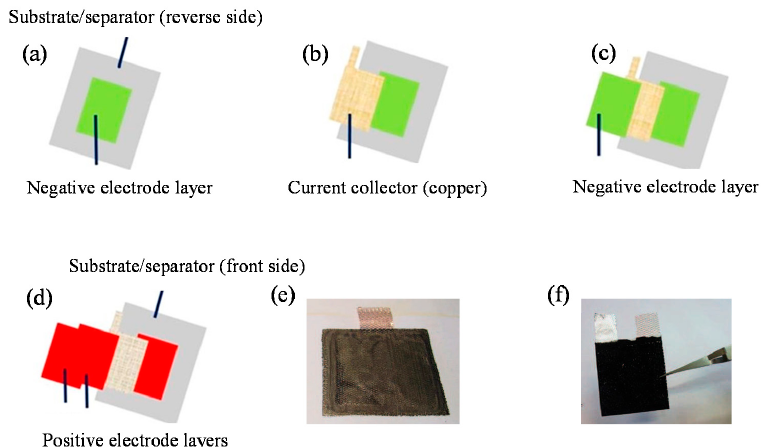
Figure 2. Schematic diagram showing the fabrication of the front/reverse assembled battery. ( a ) The negative electrode is printed onto the reverse side of the substrate; ( b ) the current collector is integrated in the structure, and ( c ) fixed with another printed layer. ( d ) On the front side of the substrate, the positive electrode is printed, but this time, the number of printed layers is modulated in order to match the capacity of the electrode. ( e ) Example of the electrode after the embedding of the current collector. ( f ) As a last step, the battery is assembled, with positive and negative components printed onto the front and reverse sides of the substrate.